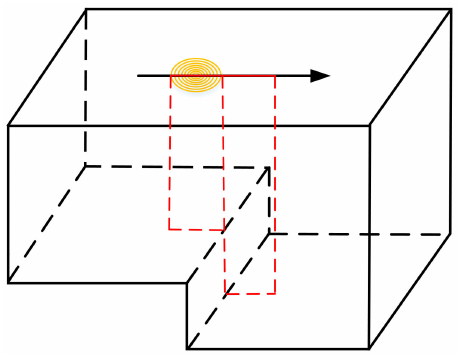
Figure 9. Relative position of transducer coil and step surface.